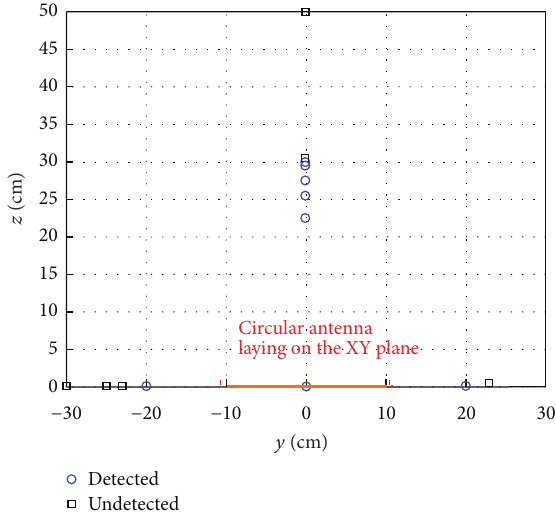
F 8: Experimental points of detection, LF RFID system.